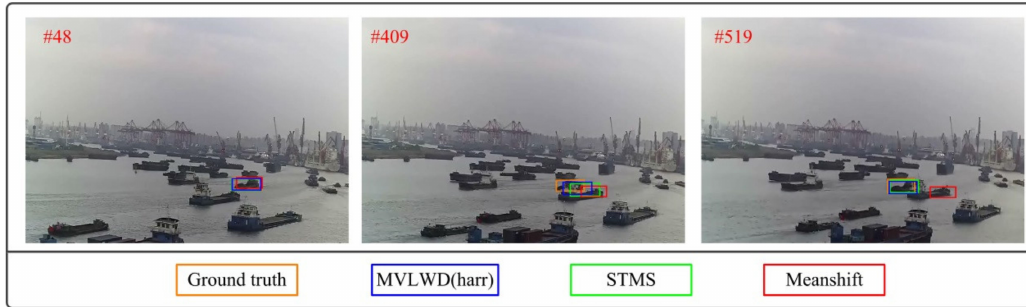
Figure 4. Ship tracking results for the three trackers on typical frames in video